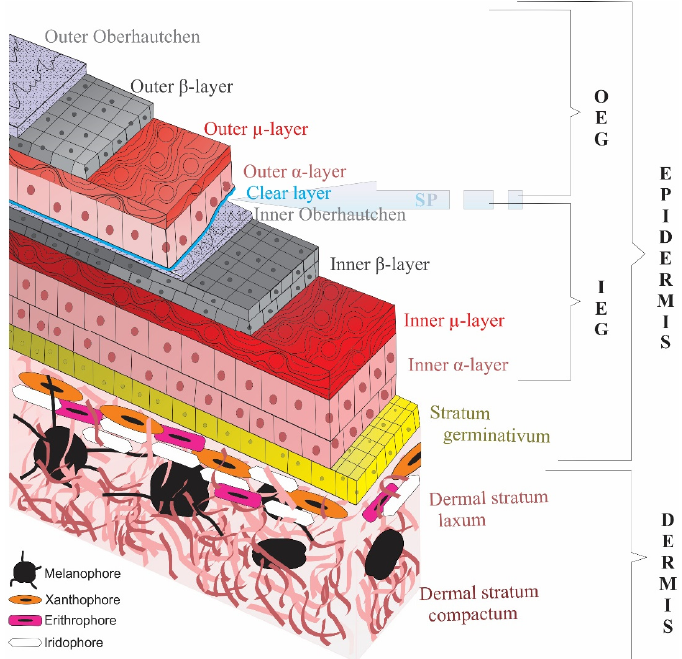
Figure 3. A general illustration showing layers of lepidosaurian skin. The Shedding Plane (SP) is separating the inner (IEG) and the outer epidermal generation (OEG) apart. Oberhäutchen, beta ( β ), mesos ( μ ) and alpha ( α ) layers are present in both generations. However, the outer generation also has a clear layer between the outer alpha and inner Oberhäutchen layers at the time of shedding. Dermis contains chromatophores giving lepidosaurians multifarious appearances (Adapted from Yenmi ş , 2022 [88]). Related to this, specific glycine ‐ cysteine ‐ rich CBPs have been found in the Ober ‐ häutchen layer of some reptilians, indicating the formation of the shedding plane, e.g., the Sn ‐ cys ‐ 1 protein, begins to form in the embryonic Oberhäutchen layer in the snake embryo in preparation for in ‐ ovo shedding, which takes place 1–2 weeks before hatching. The ab ‐ sence of this protein in other Lepidosaurs and Archelosaurs indicates that this CBP is spe ‐ cific for the snake shedding cycle [2,75,89]. 5. History of the Armor: Origin and Evolution IKSs are present in invertebrates and chordates and the central domain of these pro ‐ teins is thought to have formed one billion years ago. The first amniotes of the Carbonif ‐ erous that had IFKs had evolved a different locus than IFK genes, which is called the EDC. All the vertebrates have both IFK and EDC loci. Yet the gene clusters within are clade specific. CBPs that are sauropsid ‐ specific proteins evolved within the sauropsid EDC. The core ‐ box of the CBPs is highly conserved among sauropsids and even the translocated locus of Chelonian ‐ Avian claw CBPs are phylogenetically related to EDC genes, which led the researchers to suggest an ancestral EDC locus as a precursor [26,90–92]. Reptiles were able to colonize the terrestrial environment due to the changes in the epidermal structures, and the initial adaptation for this was the movement of the keratino ‐ cytes from the basal layer to the upper epidermal layers. After that, CBPs became variable